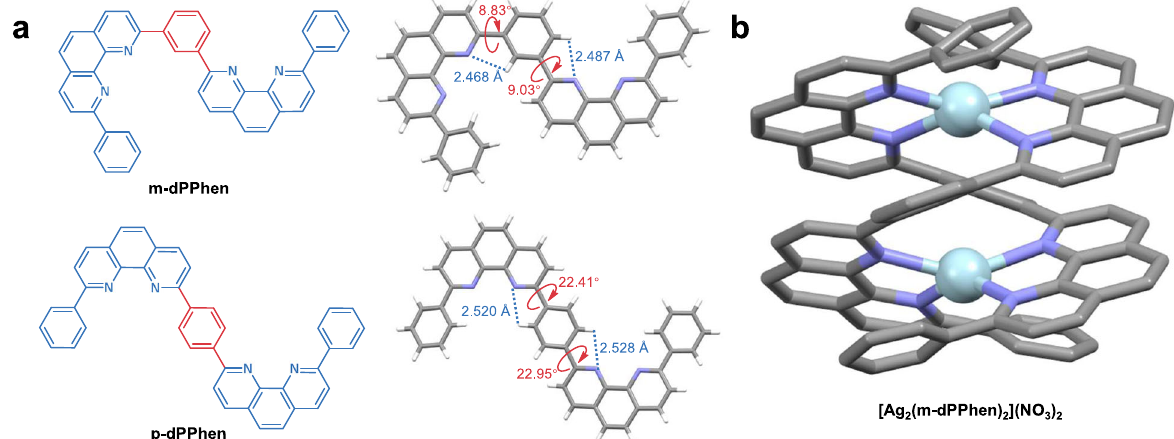
Fig. 1 The molecular structures of different diphenanthroline ligands and double-helical metal complexes. a Molecular structures and single-crystal structures of p-dPPhen and m-dPPhen. b Single-crystal structures of [Ag 2 (m-dPPhen) 2 ](NO 3 ) 2 .